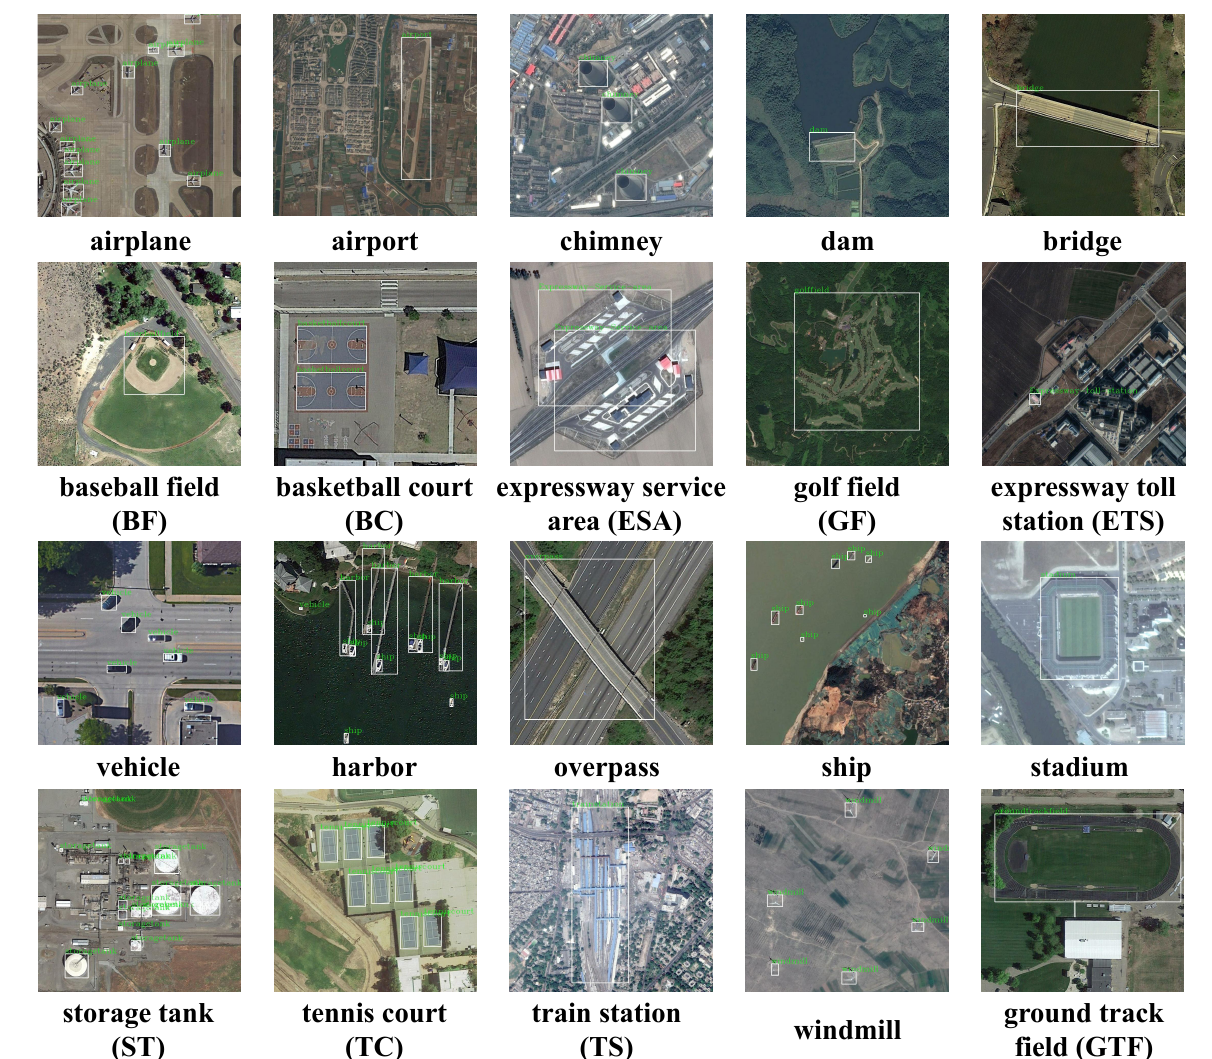
Figure 6. Object categories in the DIOR dataset. The white rectangles represent the ground truths in each